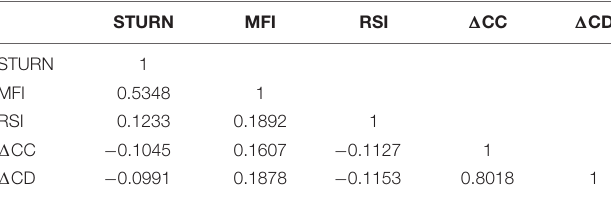
TABLE 3 | Ordinary correlations (United